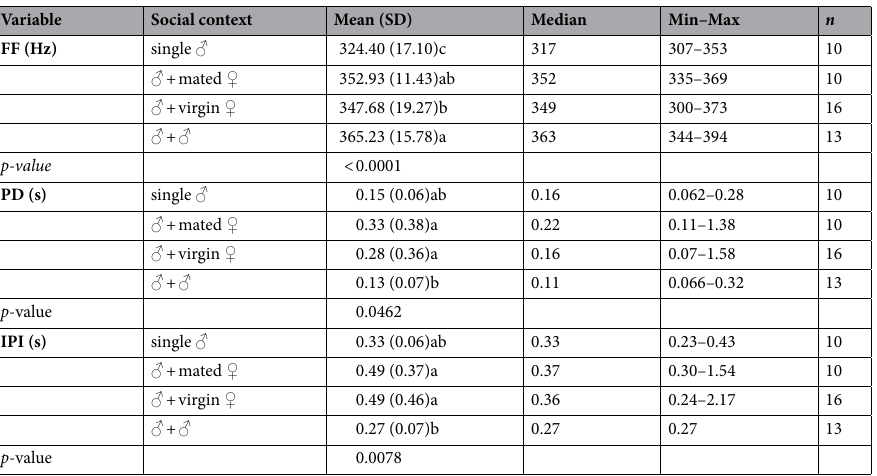
Table 3. Fundamental frequency (FF), pulse duration (PD), interpulse interval (IPI) (mean (SD), median, range and sample size) of the sound produced by the wing vibration/stridulation of a single virgin male and in the presence of a mated female, a virgin female and a male. Means within the same group followed by different letters are statistically different (level of significance α = 0.05). For FF: One-way Anova and Tukey post-hoc test. For PD and IPI: Kruskal–Wallis H test followed by Mann–Whitney U test pairwise